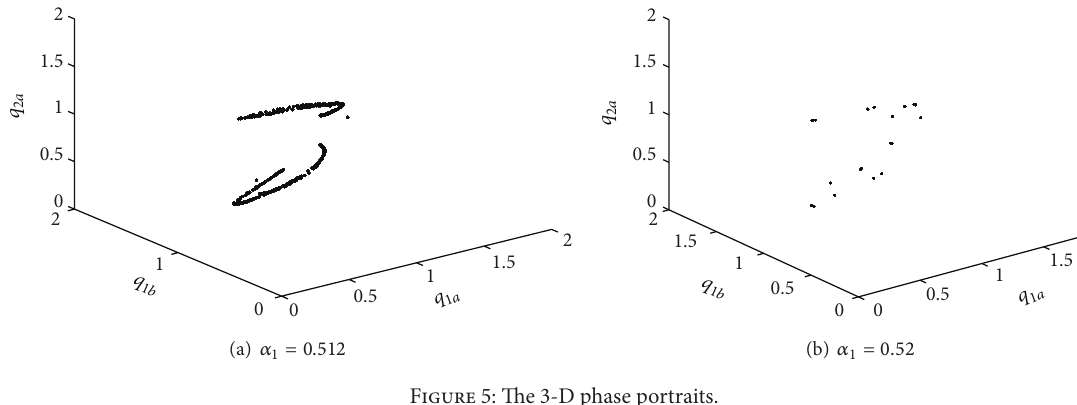
Figure 5: The 3-D phase portraits.